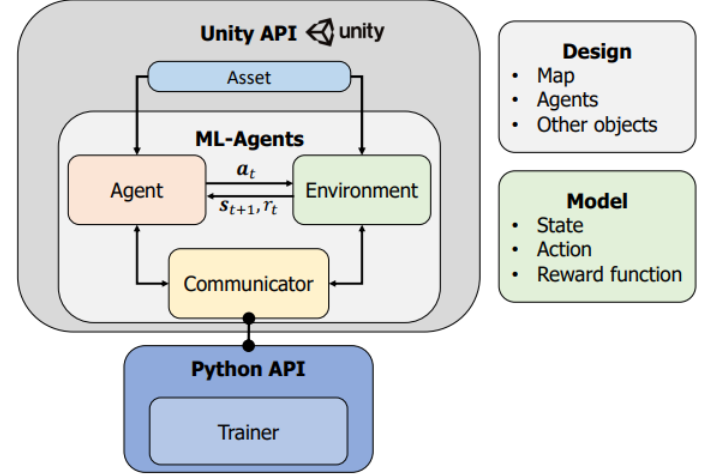
Figure 2. Unity ML structure.